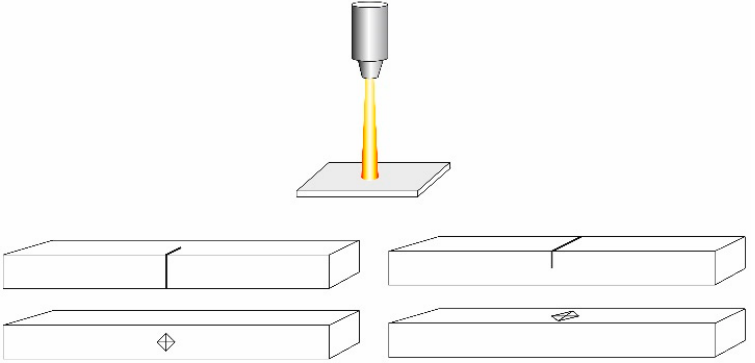
Figure 10. Illustration of crack directions / notches and hardness indentations with respect to the coating process; on the left in the horizontal direction and on the right in the vertical direction.